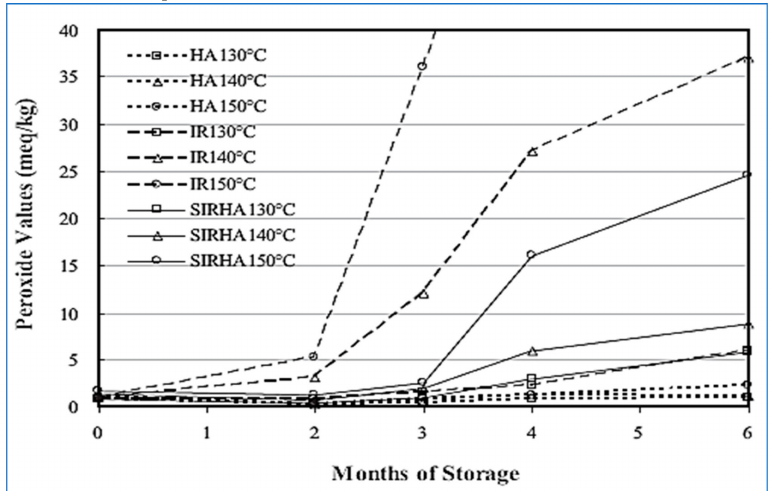
Figure 7. Changes in peroxide value of roasted almonds with IR and IR with hot air during storage at 37 ◦ C